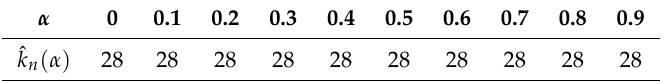
Figure 3. The plot graph of the annual flow of the Nile River from 1871 to 1970. Similar to Table 1, the values of ˆ k n ( α ) are given in Table 2. Table 2. The values of ˆ k n ( α ) based on the Nile River data.